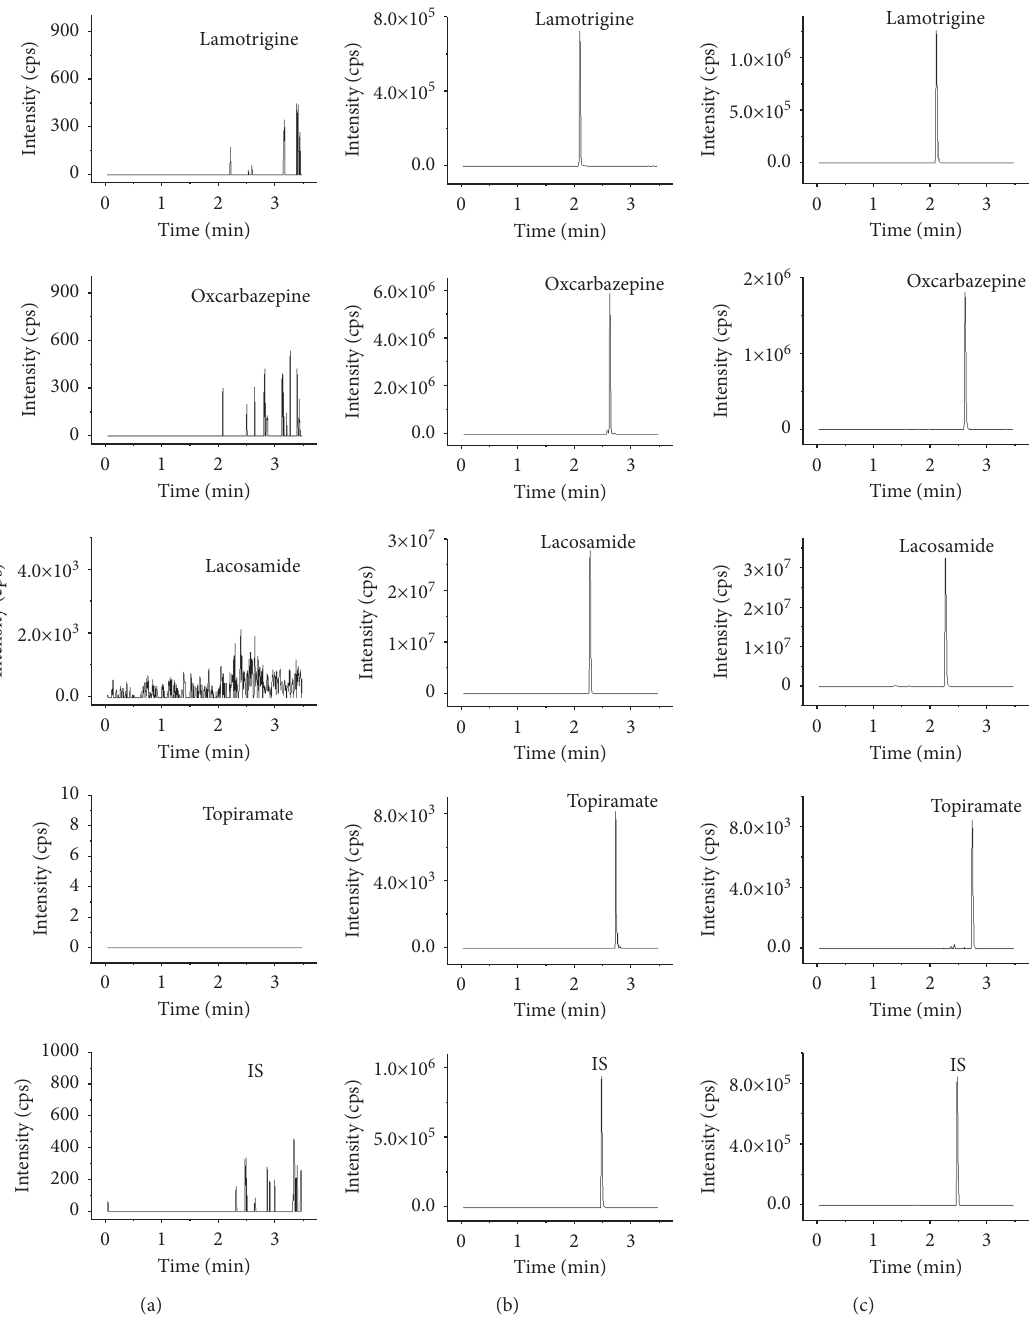
Figure 3: UPLC-MS/MS chromatograms of lamotrigine, oxcarbazepine, lacosamide, topiramate, and internal standard in rat plasma samples. Blank plasma sample (a); blank plasma spiked with lamotrigine and oxcarbazepine, lacosamide, topiramate, and internal standard (b); a rat plasma sample after the administration of the lamotrigine, oxcarbazepine, lacosamide, and topiramate (c). Table 1: The equations of the standard curve of lamotrigine, oxcarbazepine, lacosamide, and topiramate in rat plasma. Compound Equations R 2 Range (ng/mL) LLOQ (ng/mL) Lamotrigine y � 0.0005 x +0.0008